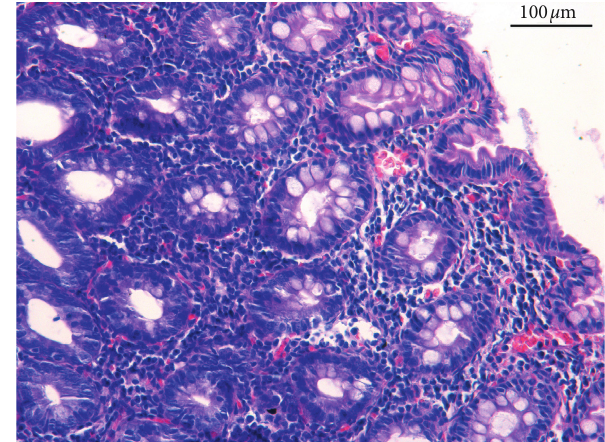
Figure 2: The microscopic view of infiltration of inflammatory cells observed in LPC.